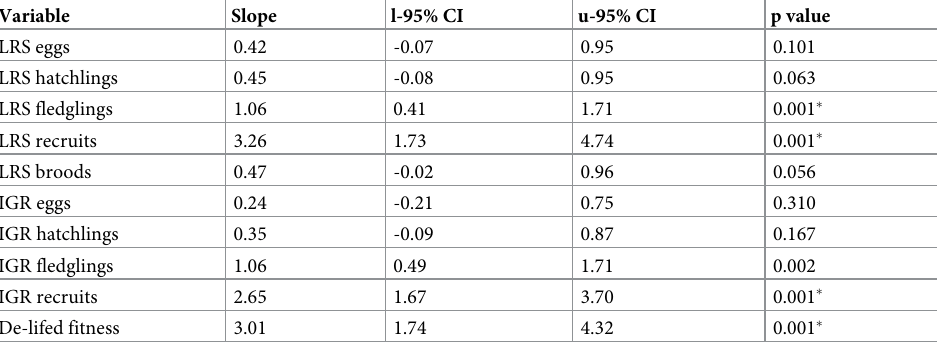
Table 2. Results of binary logistic regressions with lineage survival as a response variable. l-95% CI and u-95% CI are the lower and upper boundaries of the 95% confidence interval for the slope,